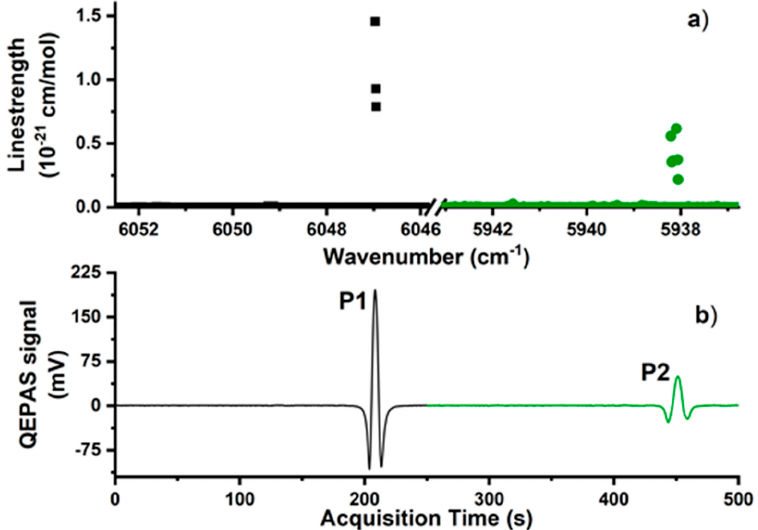
Figure 2. ( a ) Linestrength of methane absorption lines in the spectral ranges swept by LD1 (black dots) and LD2 (green dots). ( b ) 2f-QEPAS signal for a mixture containing 0.1% methane and 99.9% nitrogen obtained by scanning along the full dynamic range of LD1 (black curve) and LD2 (green curve). The QEPAS signals of the C1 peaks in LD1 range and LD2 range were 196.25 and 50.49 mV, respectively. Ethane QEPAS spectrum in Figure 3 was obtained by flushing a 1% ethane–99% nitrogen gas mixture through the ADM.